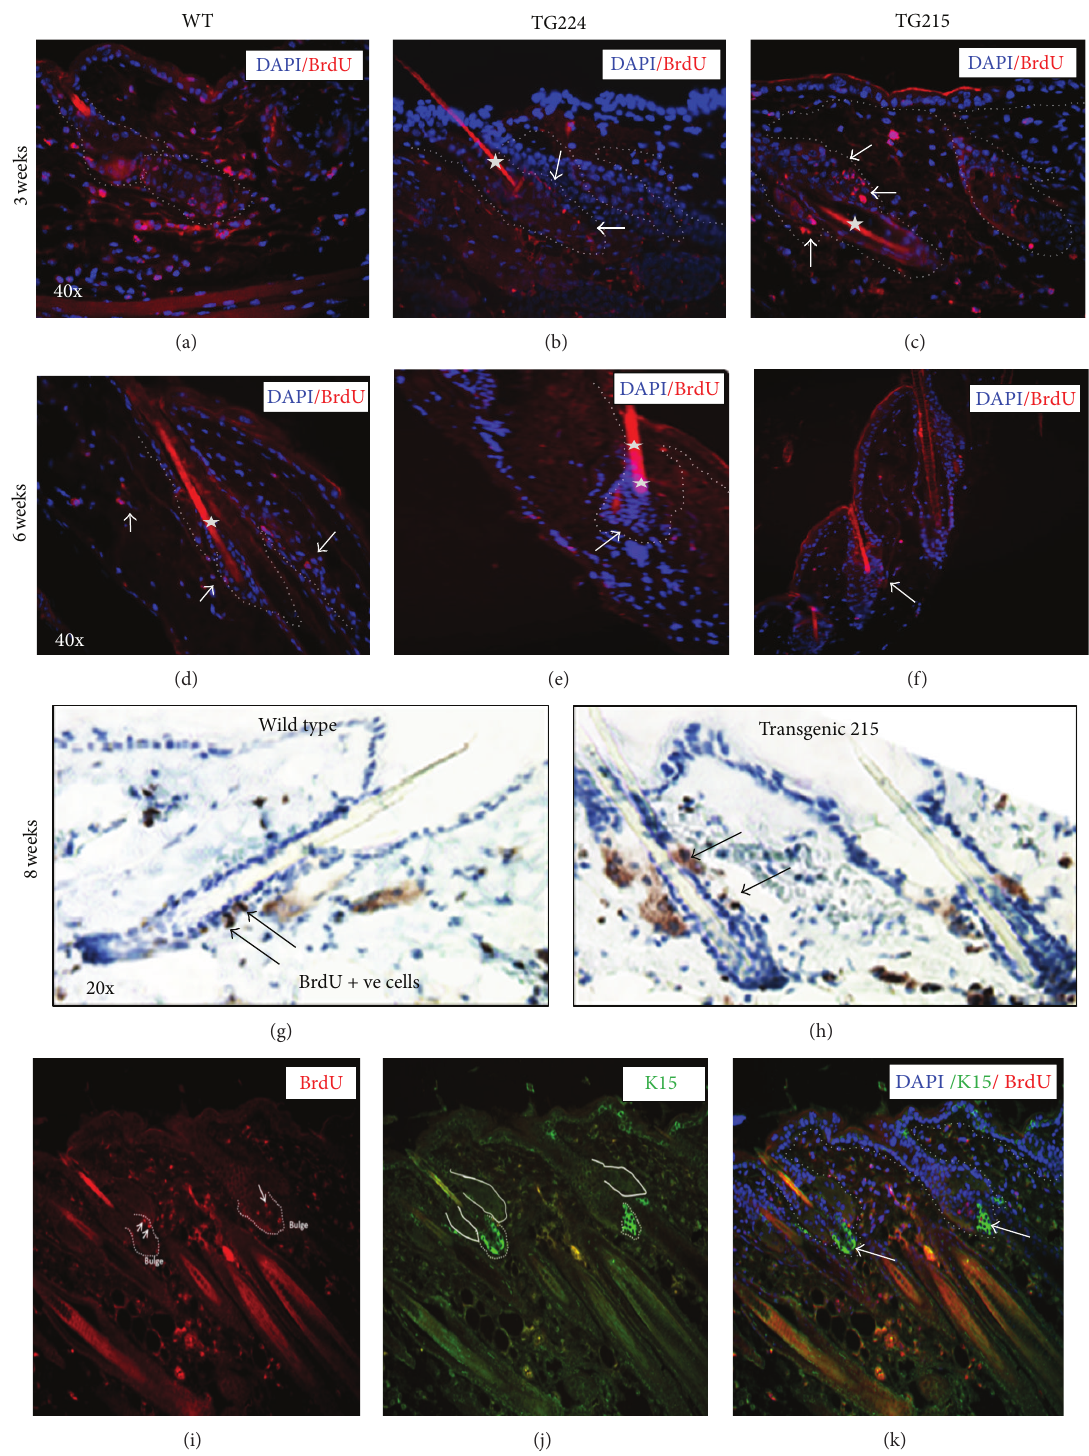
Figure 4: Detection of label retaining cells (LRC) by immunostaining using antibody to BrdU: to identify the LRCs, newborn mice (3 days old) were injected subcutaneously with BrdU (50mg/kg body weight) twice daily for 3 days. Mice were sacrificed at 3, 6, and 8 weeks after BrdU injection. Shown are the representative photographs of BrdU-labeled cells from paraffin-fixed skin sections from WT and TG mice. The white arrow points to BrdU positive cells in the bulge region of hair follicle. In all the figures, the asterisk is the autofluorescence of the hair shaft. The incorporation and retention of BrdU are shown in the various parts of hair follicle at 3, 6, and 8 weeks in the indicated mice (a)–(h). (i)–(k) are showing the dual labeling of BrdU and k15 expressing cells in the bulge region of hair